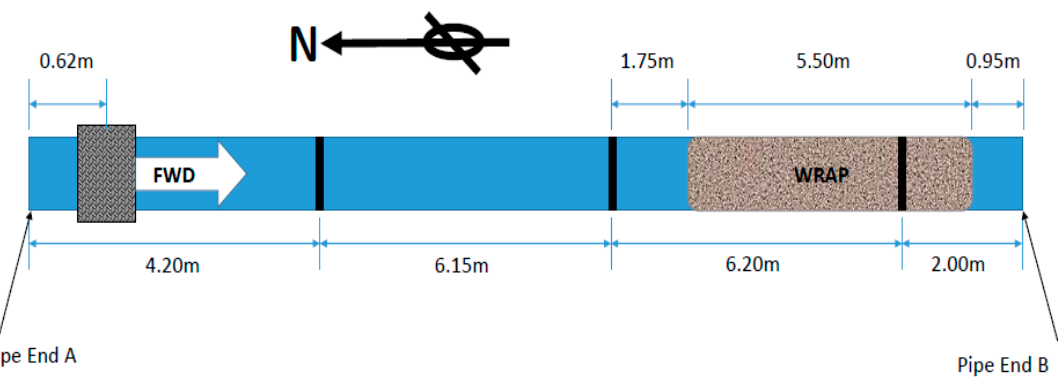
Figure 6. Experimental setup of Pipe A after coating.